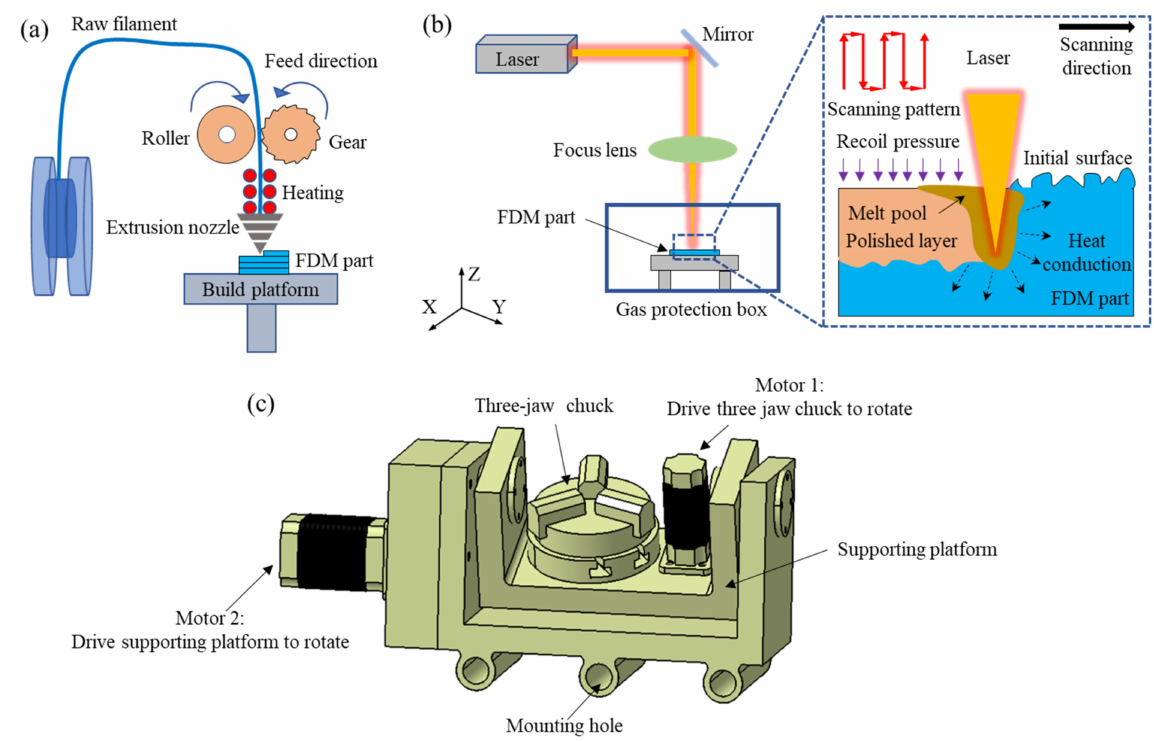
Figure 2. The process for 3D-printed PLA components: ( a ) schematic representation of FDM process; ( b ) schematic representation of laser polishing; ( c ) rotary machining platform.